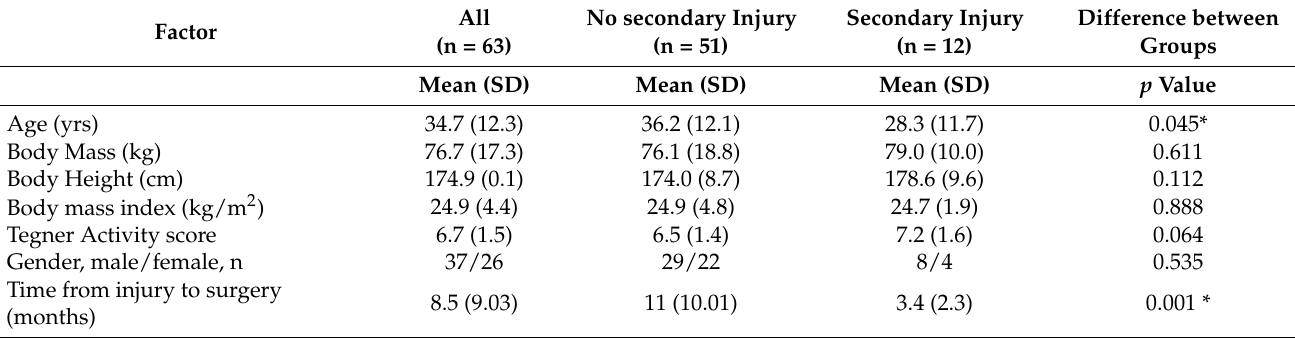
Table 1. Patient demographic data and preoperative